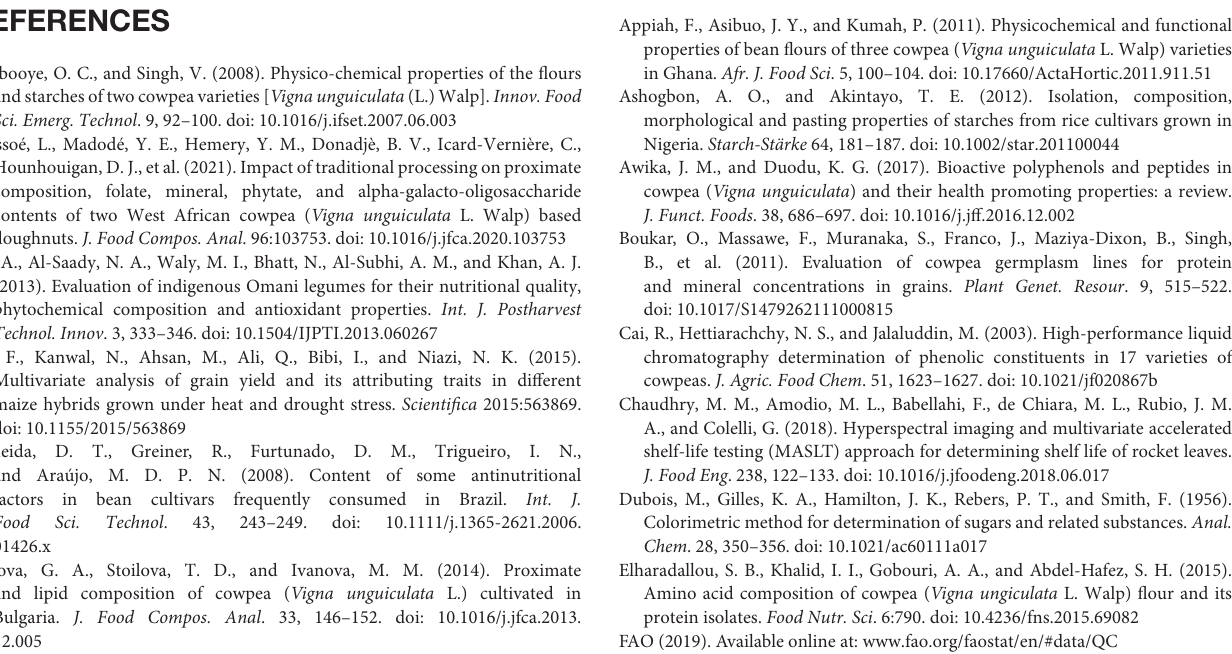
Supplementary Figure 1 | NIRS spectra of 475 cowpea samples. Supplementary Figure 2 | Range of variability for protein, starch, amylose, TDF, TSS, phenols, and phytic acid of 120 cowpea germplasm lines are represented by box-and-whisker plots. Supplementary Figure 3 | Cluster dendrogram of 120 cowpea accessions for seven different biochemical traits. Supplementary Table 1 | Nutritional composition of 120 cowpea germplasm lines. Supplementary Table 2 | Initial eigenvalues of